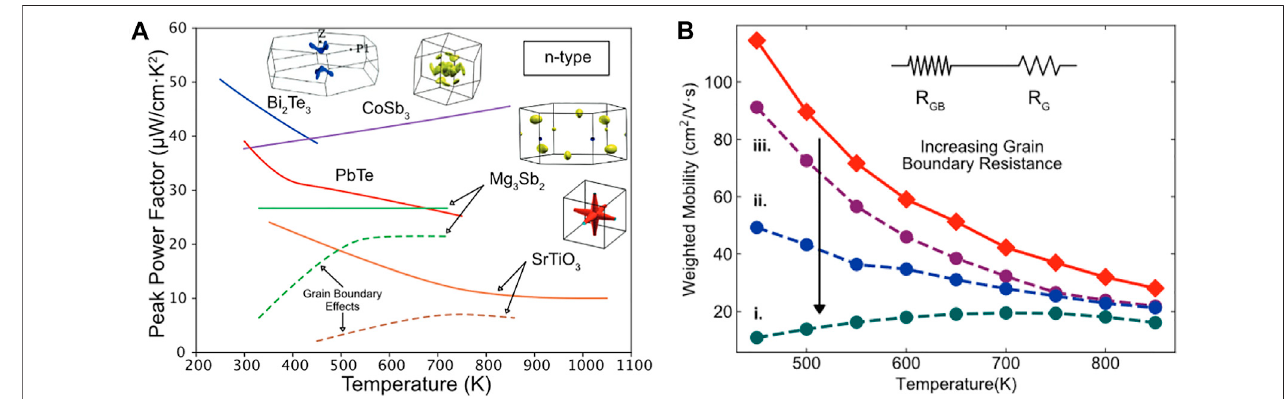
FIGURE 3 | (A) The modelled peak power factor for different thermoelectric materials showing higher values when grain boundary resistance is not considered (solid lines) compared with when they are considered (dashed lines). (B) In fl uence of grain boundaries on weighted mobility vs. temperature trend. Smaller grain (more grain boundaries) lowers the low temperature weighted mobility. Figure reproduced with permission from [86]. Copyright Wiley